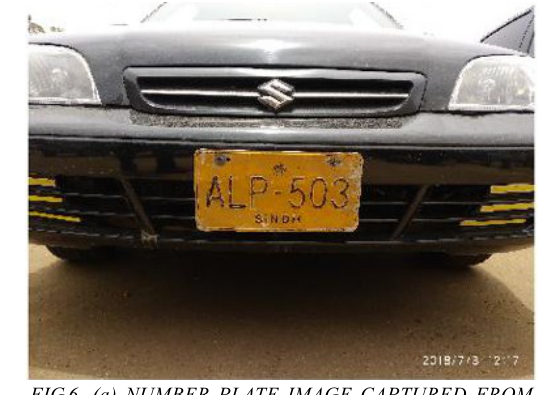
FIG.6. (a) NUMBER PLATE IMAGE CAPTURED FROM CAMERA-2